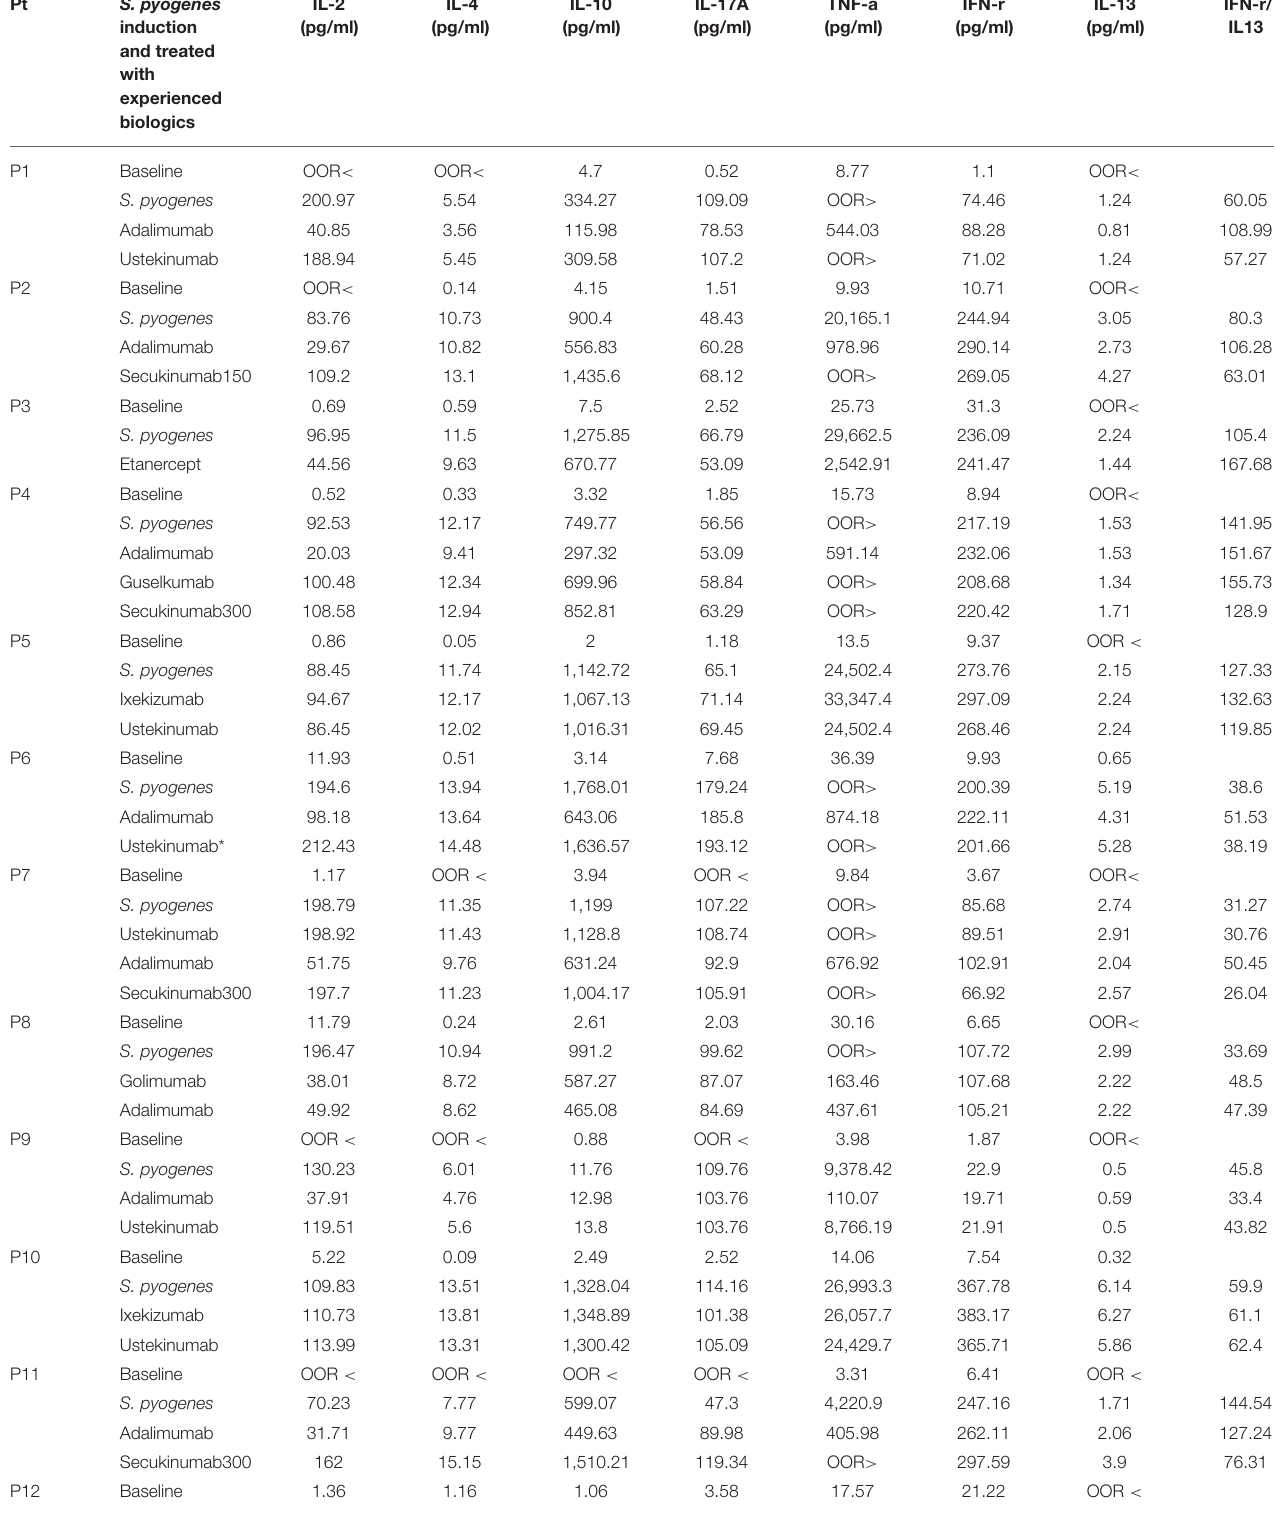
TABLE 3 | Laboratory profile of psoriasis patients with administered biologics ( n = 13).